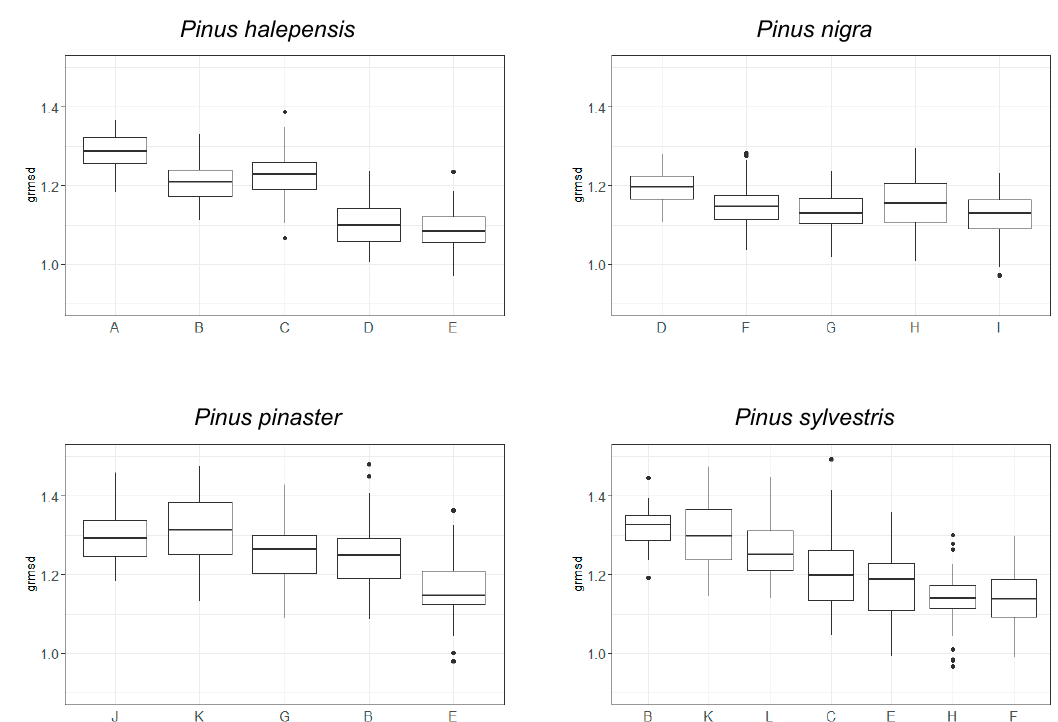
Figure 2. Selection of the best independent variables (ALS metrics) to estimate the total biomass of each species of the pine plantations at Filabres (Southern Spain) based on GRMSD (Generalized Root Mean Squared Distance), calculated as averaged mean Mahalanobis distances. The x -axis values are